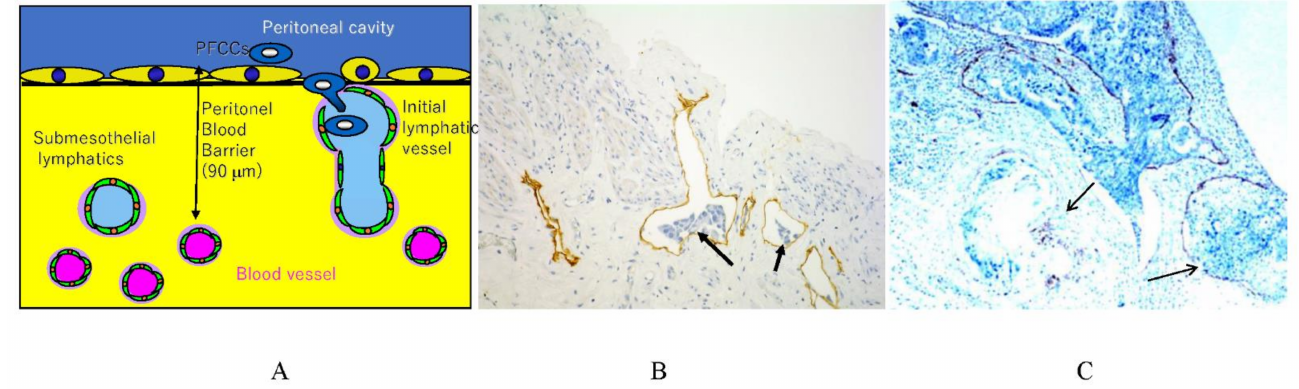
Figure 22. ( A ) Schema of trans-lymphatic metastasis. PFCCs invade the initial lymphatic vessels through mesothelial stomata and hole in the macula cribriformis. ( B ) Cancer cells (arrows) prolif- erating in the lymphatic lacuna connecting with initial lymphatic vessels (D2-40 immunostaining). ( C ) Lymphatic vessels are destroyed by the proliferation of cancer cells (arrows, D2-40 immunostain- ing), resulting in the malfunction of lymphatic